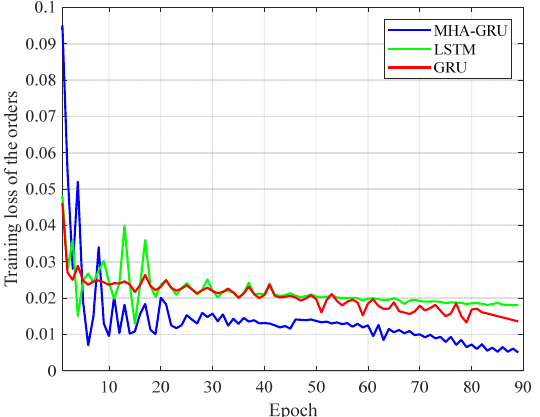
Figure 11. Training loss of different methods on training dataset.